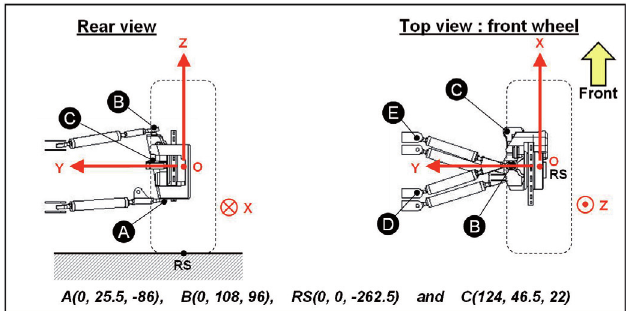
Fig. 5. Geometries of the wheel, hub and the